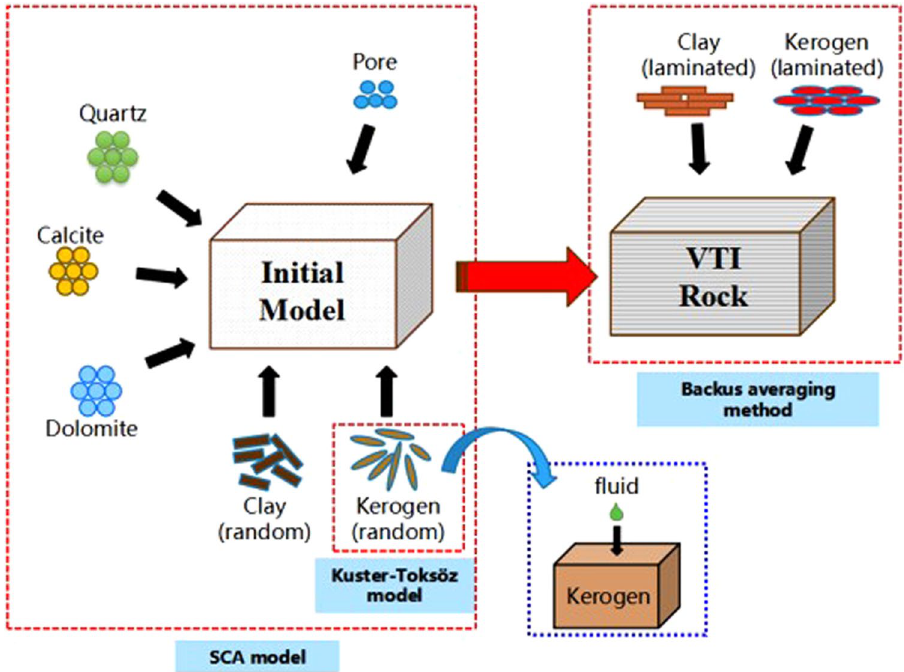
Figure 1. Schematic of the shale rock physics modelling